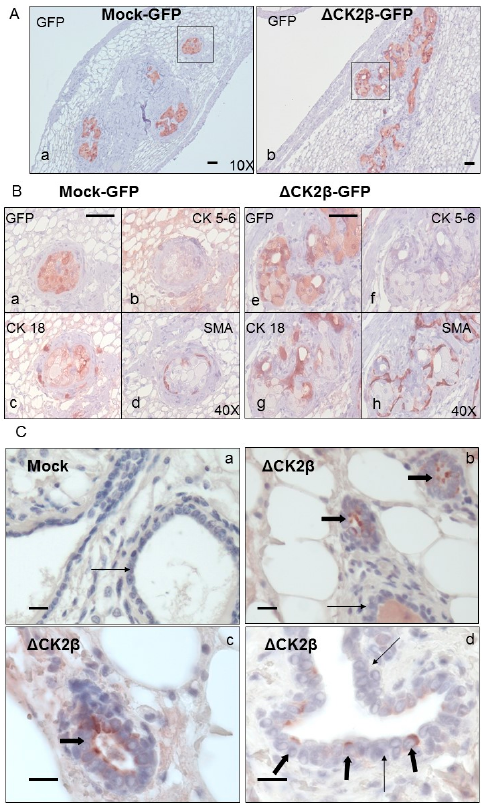
Figure 4. IHC analysis of Δ CK2 β - and Mock-MCF10A cells injected in inguinal mammary fate pad.